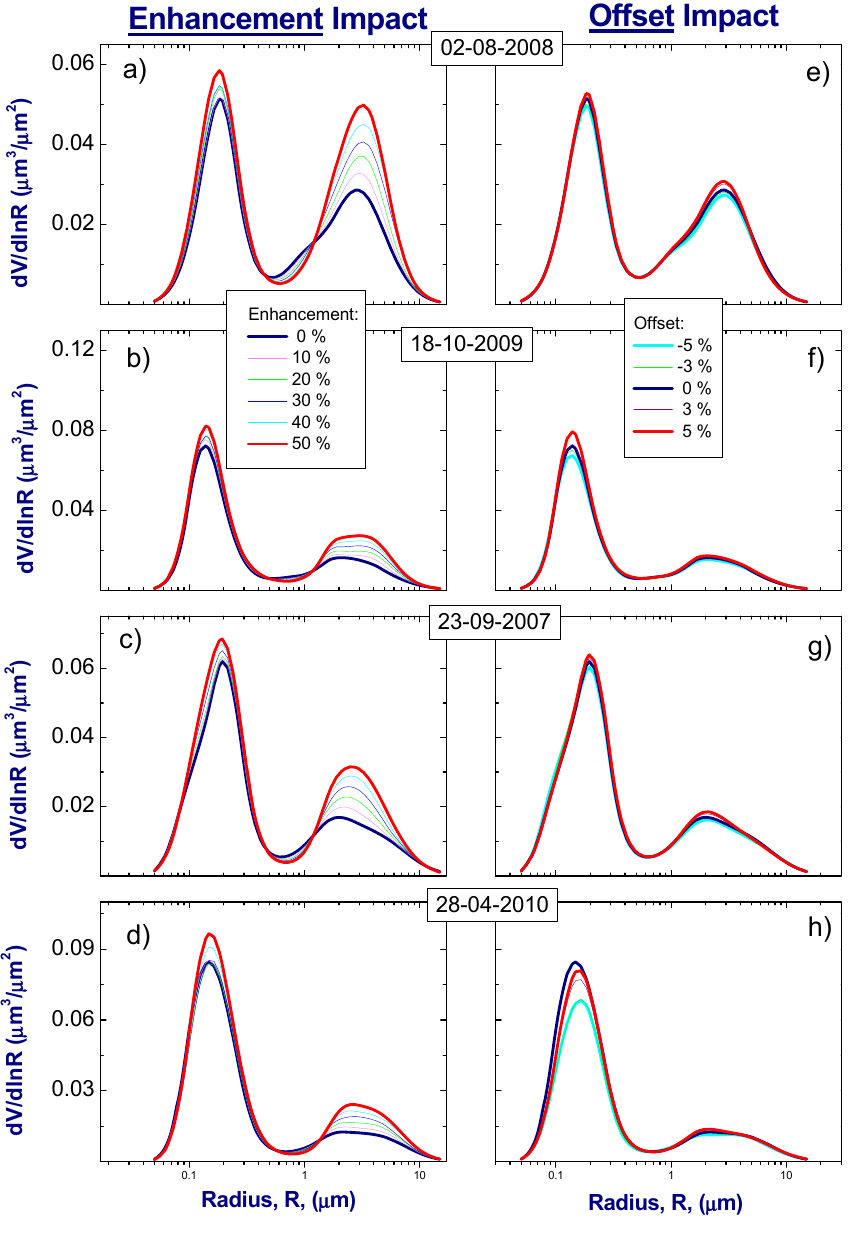
Figure 6. Volume size distributions for selected four days in the presence of enhancement (left column) and offset (right column).